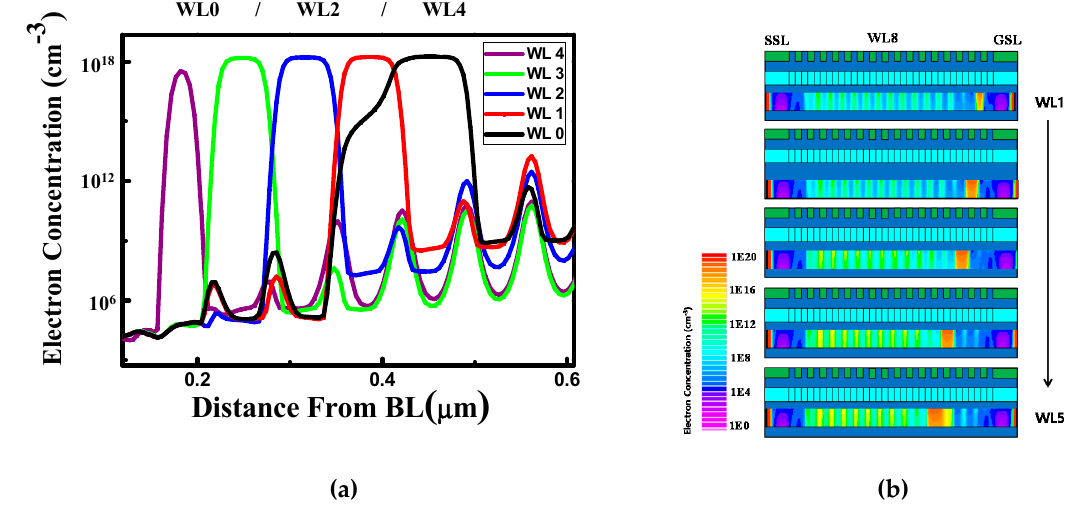
Figure 4. Electron concentration of the 3D NAND when the V PGM reaches 7.8V ( a ) electron concentration of each WL and ( b ) electron concentration profile of the channel in the real simulation device.